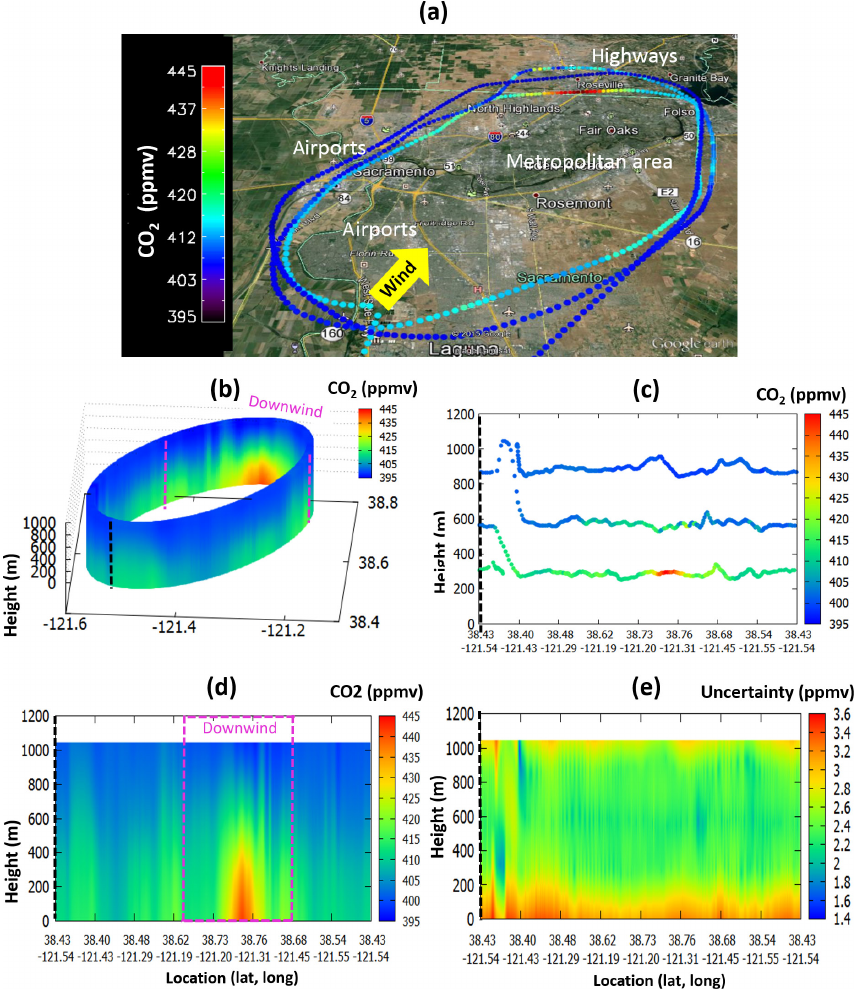
Figure 5. (a) A map of AJAX flight track overlaid by the CO 2 mixing ratio, plotted in Google ™ Earth, (b) kriged CO 2 mixing ratio, (c) measured CO 2 mixing ratio, (d) the same as (b) except plotted in two dimensions, and (e) kriging uncertainty at each grid point on 18 November 2013. The yellow arrow represents the dominant wind direction, and the black dashed line indicates where the surface is split open. The area enclosed by the magenta dashed lines represents the area we used as a downwind portion. Figures are stretched vertically by about a factor of